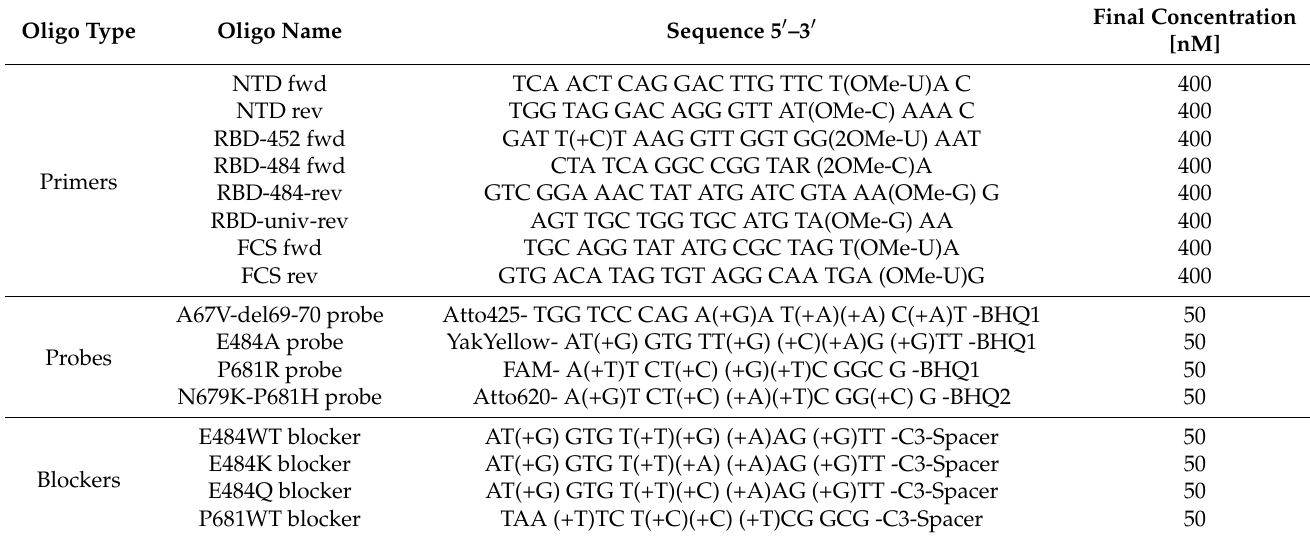
Table 1. Primer-, probe-, and blocker sequences of the multiplex assay are listed. Oligos were custom made by Ella Biotech (Fürstenfelbruck, Germany). Indicated final concentrations refer to the final oligo concentrations within the reaction mix. 2 (cid:48) O-methyl-RNA bases are indicated as “OMe-X”. LNA bases are indicated as “+X”).